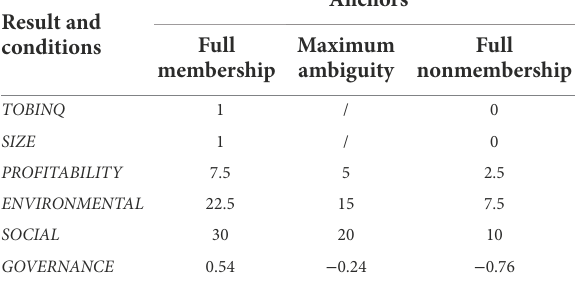
TABLE 1 Calibration of result and